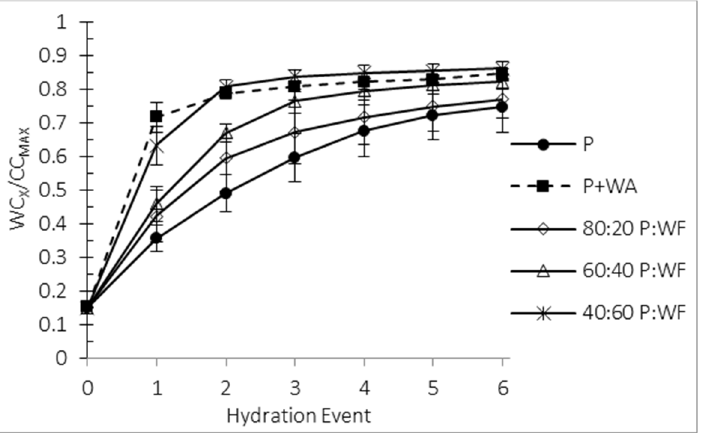
Figure 3. Cumulated water capture for comparing effects of both wetting agent incorporated in tial moisture content.